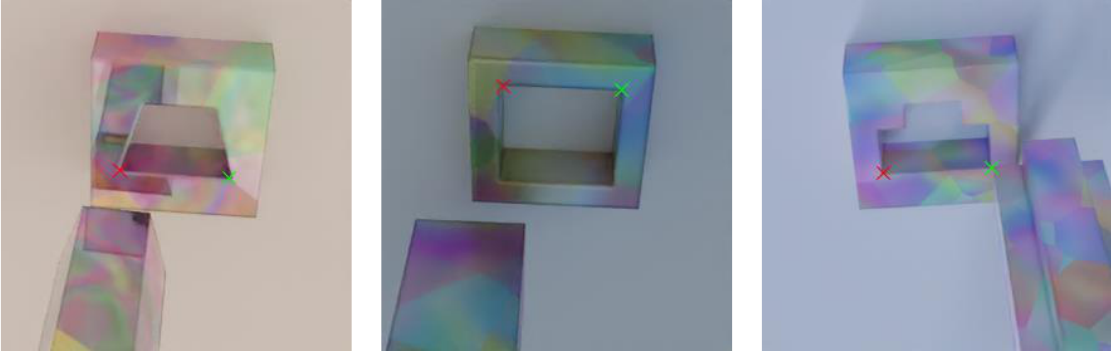
Figure 15. Workpiece landmark detection in the test set.